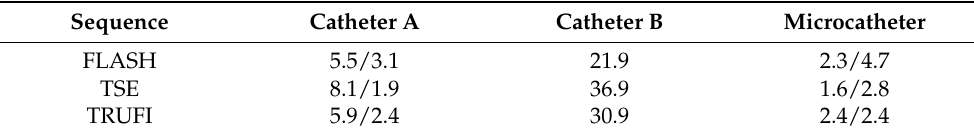
Figure 4. Visibility of three different catheters in an agarose phantom using different MRI sequences. FLASH = fast low-angle shot, TSE = turbo spin echo, TRUFI = true fast imaging with steady-state free precession. Table 3. Maximum artefact diameter induced by the different catheters in millimetres. The two values reported for catheter A represent the majority of the catheter length (left), and the thinner, distal 10 cm of the catheter (right). The two values reported for the microcatheter represent the shaft (left) and the marker at the tip (right).